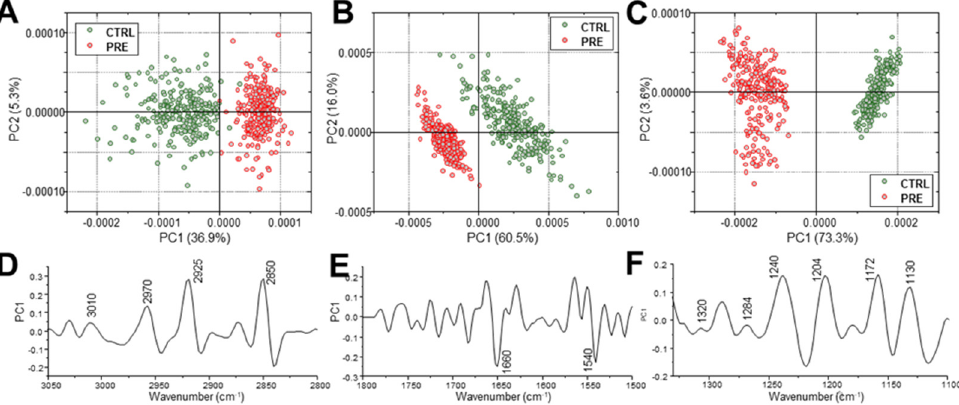
Figure 4. Multivariate analysis on IR spectra. PCA scores plots and corresponding PC1 loadings calculated for CTRL and PRE experimental groups in the following regions of interest (ROI): 3050–2800 cm − 1 ( A , D ), 1800–1500 cm − 1 ( B , E ), and 1330–1100 cm − 1 ( C , F ). For clarity purposes, PCA loadings are plot with different Y scales for the three selected ROI.